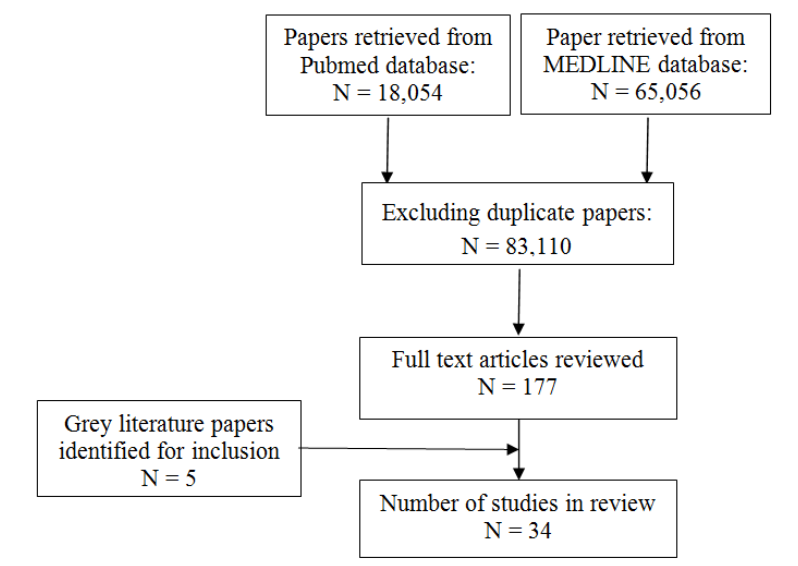
Figure 1. Selection of articles for review *